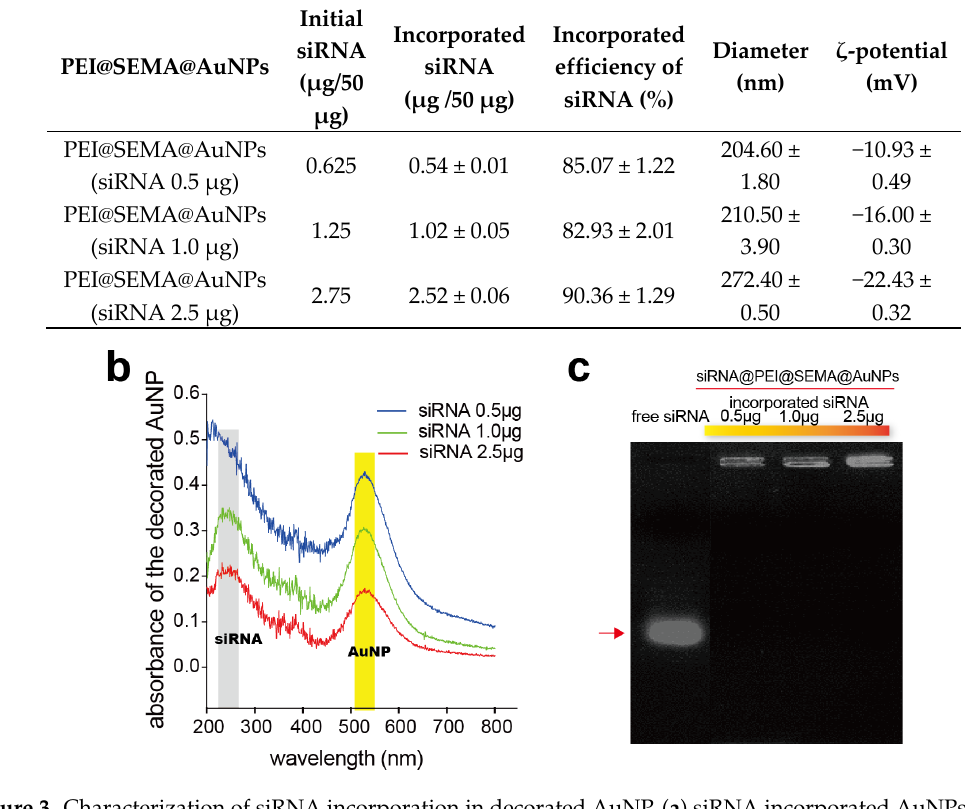
Figure 3. Characterization of siRNA incorporation in decorated AuNP. ( a ) siRNA incorporated AuNPs were characterized for incorporation e ffi ciency, diameter, and surface charge. A fixed amount (50 µ